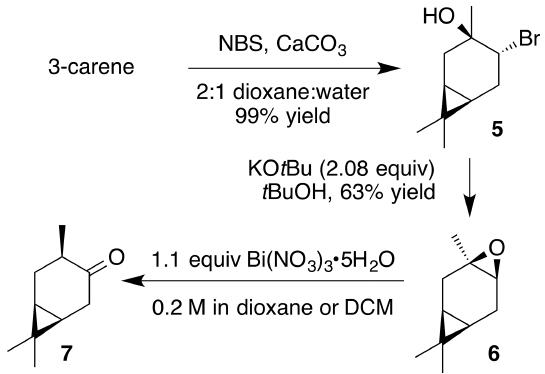
Figure 3. Preparation of cis -3-carene oxide and attempted